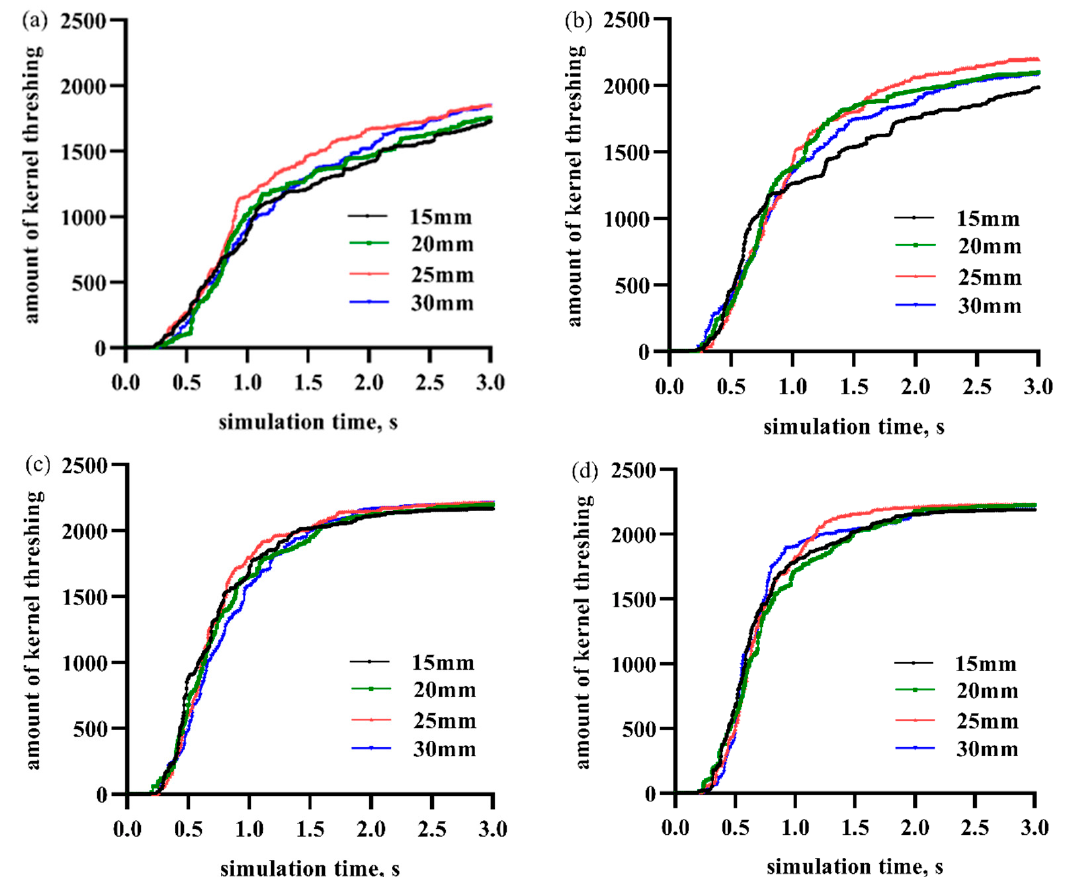
Figure 7. Effects of the width of threshing component on the amount of kernel threshing at the rate of drum rotation of ( a ) 122.70 rpm, ( b ) 187.15 rpm, ( c ) 252.10 rpm and ( d ) 317.15 rpm.